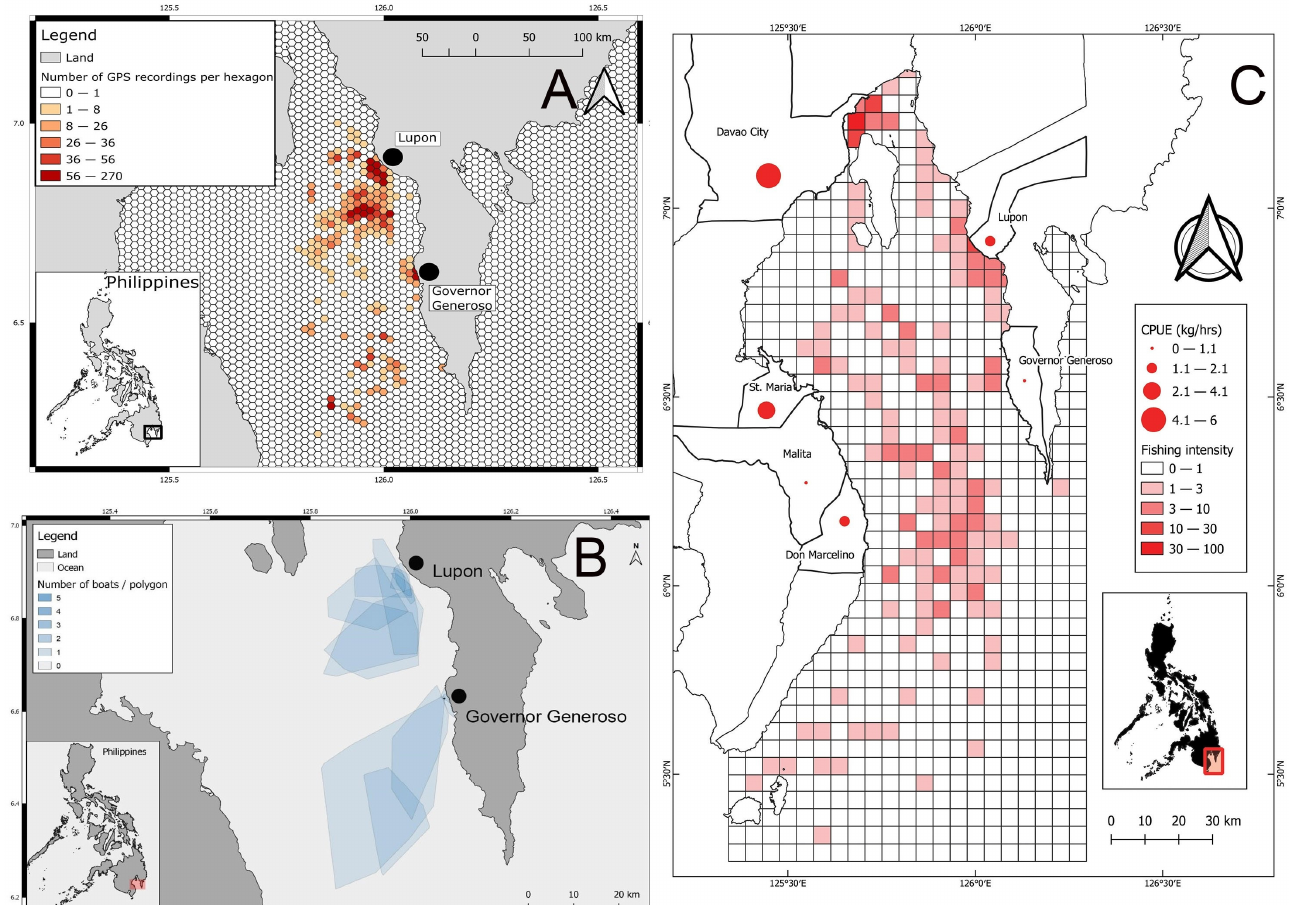
Figure 4. Fishing grounds identified in the eastern side of the Davao Gulf: ( A ) shows the density of GPS recordings from the boats departing from Lupon and Governor Generoso (number of GPS recordings inside each hexagon is indicated in the legend of each map); ( B ) shows intensity of fishing effort estimated by number of boats (darker blue polygons represent more fishers have been observed fishing in that area); ( C ) shows the interview map used to validate the outcome of the GPS tracking, showing the various fishing grounds of fishers from Davao Gulf including their fishing intensity.